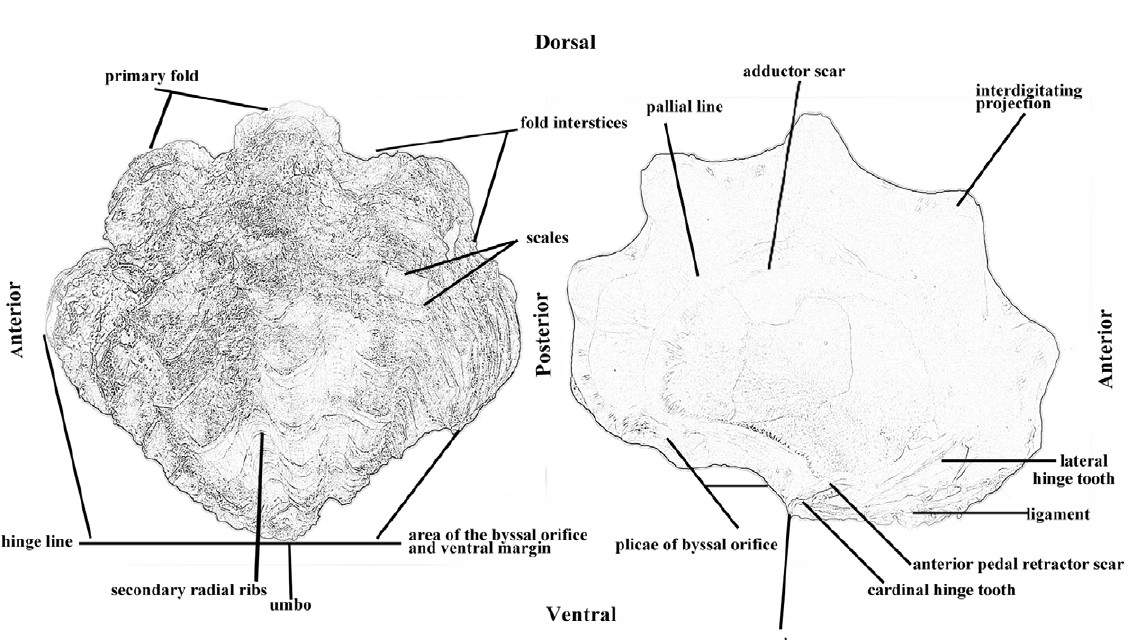
Figure 2. Generalised diagram of a bivalve